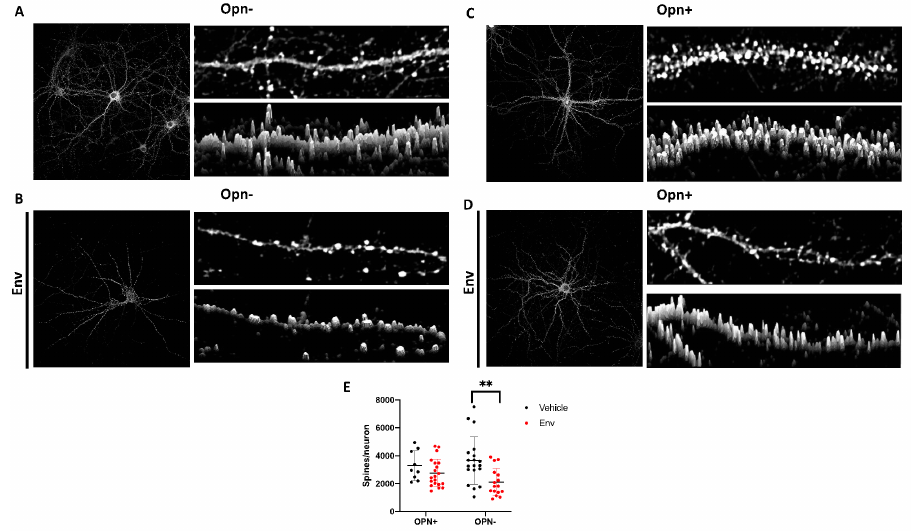
Figure 1. Opn counteracts HIV-1 Env mediated post-synaptic damage. Representative images of primary hippocampal neurons treated with vehicle ( A ), Env only ( B ), Opn only ( C ), and Env + Opn ( D ) are shown. Left panel shows image of the entire neuron and on its top-right is a section of the dendrite and 3D construction of the dendrite section below it. ( E ) shows grouped interleaved scatter graph for the number of synapses per neuron due to the four di ff erent treatments. The mean deviation (SD) are shown with the following number of sampling for each groups: n = 4 and 45 neurons for vehicle treated neurons, n = 3 and 34 neurons for Env only, n = 3 and 13 neurons for Opn only and n = 4 and 52 neurons for Env + Opn. Two-way ANOVA with Tukey’s post-test was performed to reveal statistical di ff erence between groups (** p <